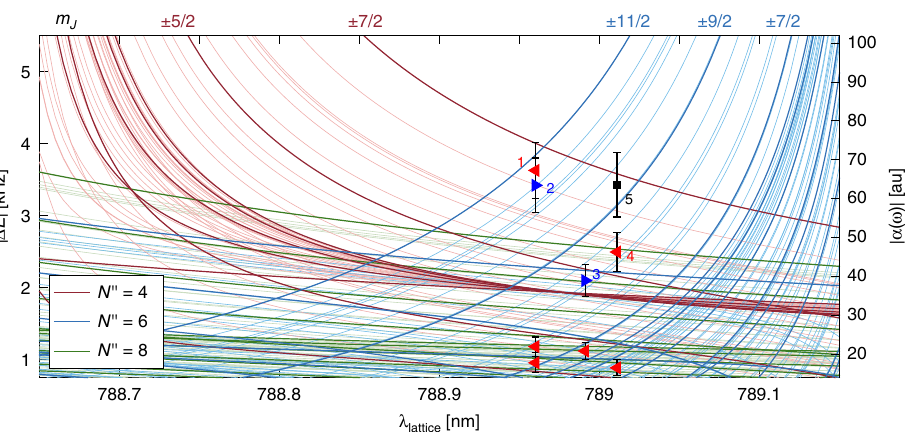
Fig. 4 Molecular-state identi fi cation. Absolute magnitude of the ac-Stark shifts (left ordinate) and the molecular dynamic polarizability (right ordinate) for molecules in the N ″ = 4, 6 and 8 rotational states (red, blue and green lines) at a lattice-laser wavelength around 789 nm. Thick lines correspond to the ac- Stark shift of Zeeman components of the I = 0 nuclear-spin isomer without hyper fi ne structure (labelled by their magnetic quantum numbers m J ″ on top of the fi gure) while thin lines correspond to the hyper fi ne-Zeeman components of the I = 2 isomer. Blue (red) triangles represent experiments in which the measured ac-Stark shifts were stronger in the OP (SP) con fi guration corresponding to a lattice blue (red) detuned from the transition. The black square represents an experiment without the phase information. Error bars are the combined 1 σ uncertainties of the fi t to the data (Methods) and the uncertainty of the lattice laser power (~10%). The ac-Stark shifts originating from the N ″ = 0, 2 rotational levels are lower than the ones for the N ″ = 8 state in this wavelength range and were omitted for Rabi-oscillation signal from panel a to panel b indicated a possible change of the chemical composition of the molecule, which was then veri fi ed by mass spectrometry (Methods). Due to the mass change of the crystal in the reaction, the frequency difference of the lattice beams, Δ f , had to be adjusted to match the ð N new crystal frequency f SP H þ Þ ¼ 690 kHz (Methods). The 2 IP energy-level structure of N 2 H + is not suf fi ciently known to be able to clearly identify the molecular quantum state generated in the reaction. However, the phase information indicated that the lattice beams were red detuned from the relevant resonance in the N 2 H + molecule. This experiment exempli fi es the basic possibility to perform state-to-state chemical reaction experiments involving polyatomic species. The ability to perform such experiments depends on the lifetime of the product state compared to the time required for state detection.